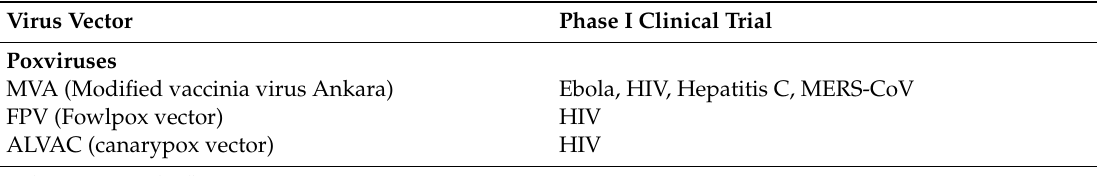
Table 2. Human clinical trials in progress with viral vectored vaccines.